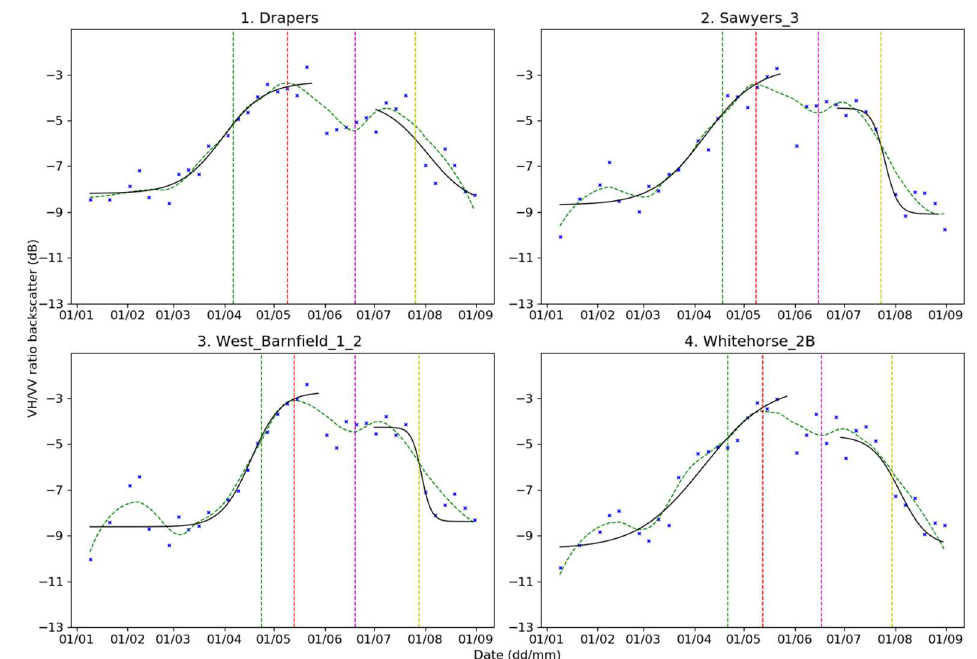
Figure 8. VH / VV ratio time series (blue dots) with the smoothed curve (green dashed line) and two logistic curves fitted (black line) for four fields (subplots 1–4) in 2019, orbit 132. The vertical dotted lines indicate the dates of G_midP (green), TZmax (red), inflorescence (purple), and S_midP (yellow), as determined from the VH / VV backscatter time series analysis.